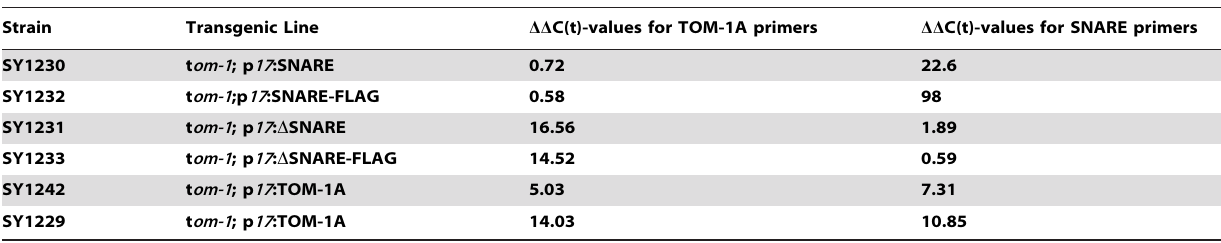
Table 1. DD Ct-values for TOM-1A transgenic lines.